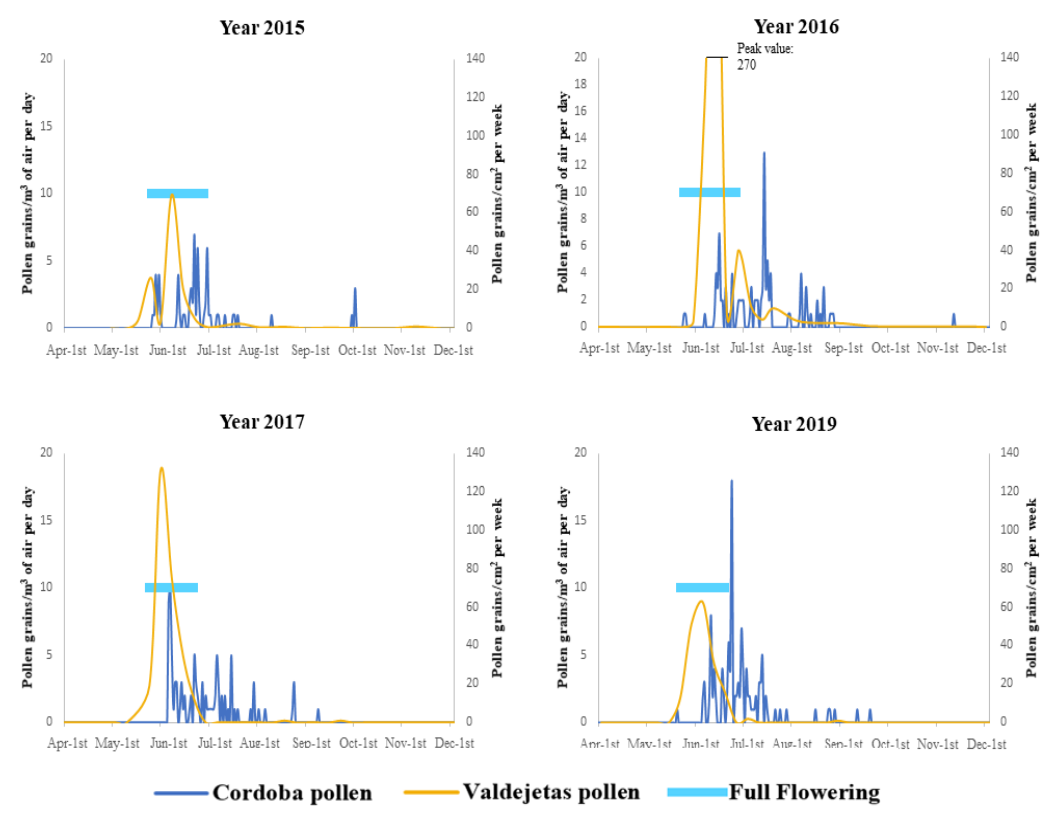
Figure 3. Castanea pollen concentrations recorded in each year of the study in each location. Pollen grains / m 3 per day in the city of Cordoba (blue line); pollen grains / cm 2 per week in the Valdejetas estate (yellow line); full flowering detected in the Sierra Morena mountains.